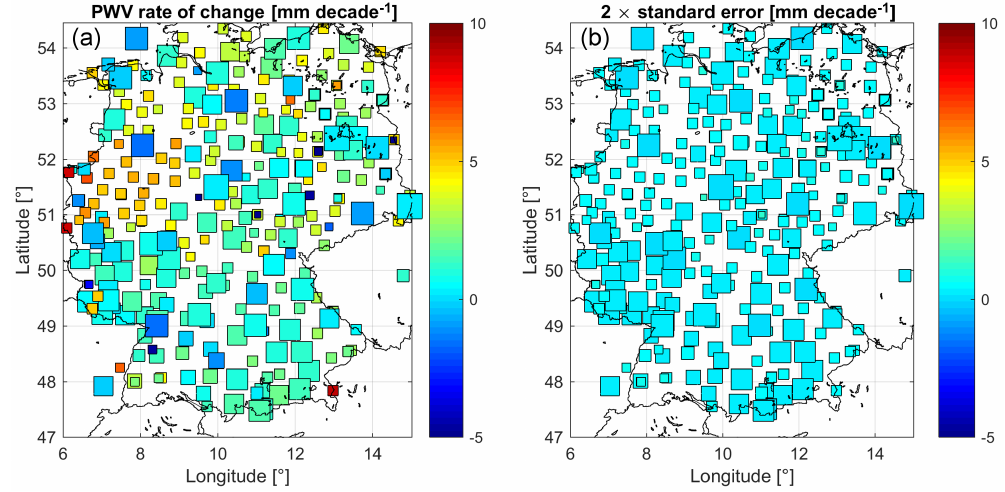
Figure 7. The estimated PWV trend at 351 GNSS sites and the corresponding uncertainty in the estimated trend using Theil–Sen estimator. The size of the marker indicates the length of the PWV time series; i.e., the larger the marker, the longer time series.